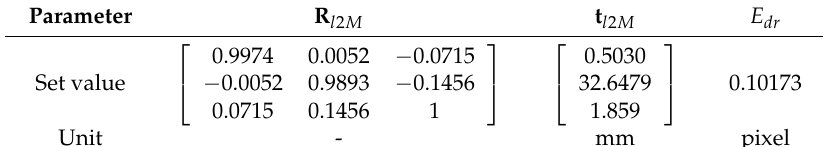
Table 5. System extrinsic parameters and evaluation error.